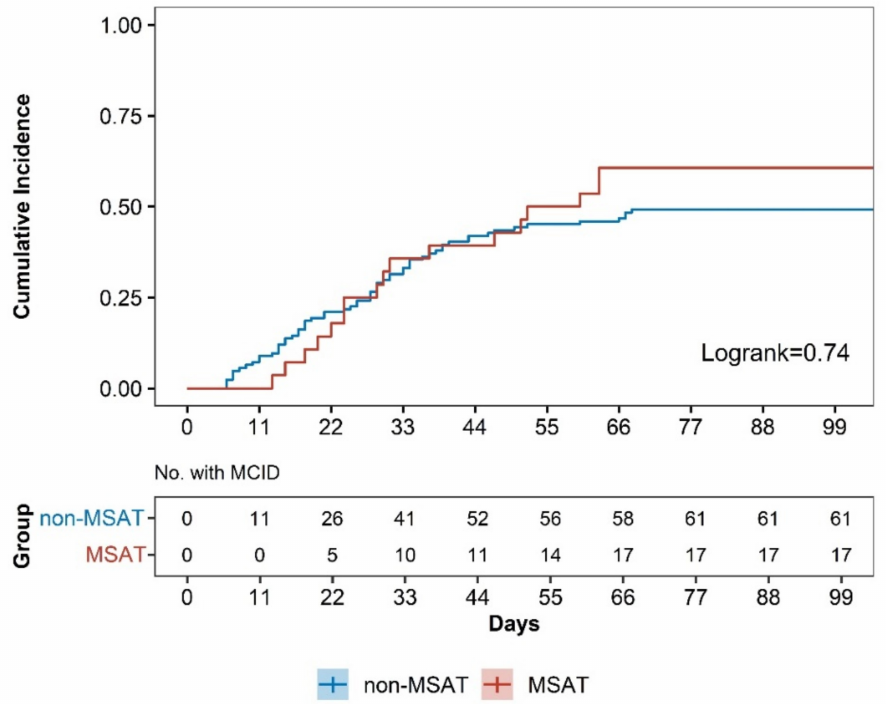
Figure 3. Survival analysis on improvement in NRS for LBP in the MSAT and n-MSAT groups. Abbreviation: minimal clinically important difference